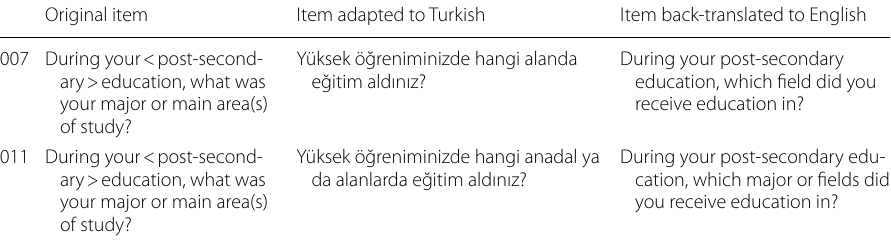
Table 1 Original items in English, their adapted versions in Turkish, and back-translations of the adapted items to English Original